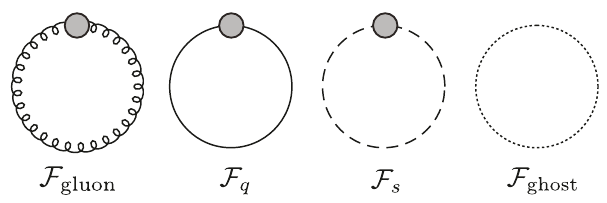
Figure 2 . One loop Feynman diagrams for N = 4 SYM theory in HTLpt. Dashed lines indicate a scalar (cid:12)eld and dotted lines indicate a ghost (cid:12)eld. Shaded circles indicate HTL-dressed